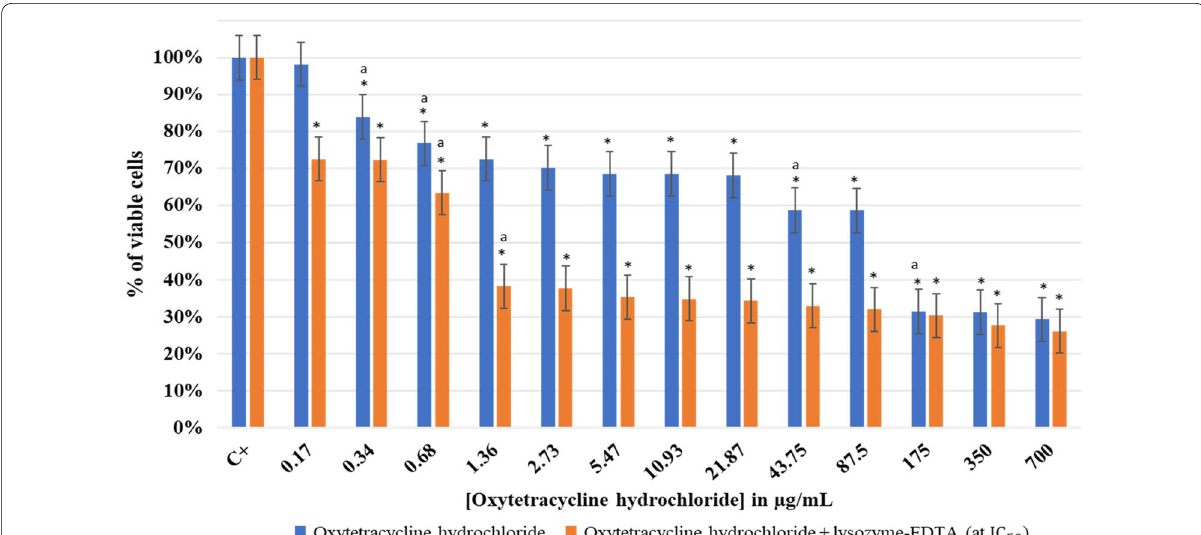
Fig. 5 Effect of oxytetracycline hydrochloride with and without lysozyme-EDTA (at IC 50 ) on planktonic Staphylococcus epidermidis 444 at pH 7.5. OD 600 negative control (oxytetracycline hydrochloride) 0.32, OD 600 of 700 μg/mL of oxytetracycline hydrochloride with lysozyme-EDTA (at = IC 50 ) 0.4. The results are mean values of three replicates. (*) indicates a significant difference (P < 0.05) between each test and the positive control = (oxytetracycline hydrochloride). The lowercase letter (a) indicates a significant difference (P < 0.05) between each test and its preceding. Error bars represent the SD (standard deviation)